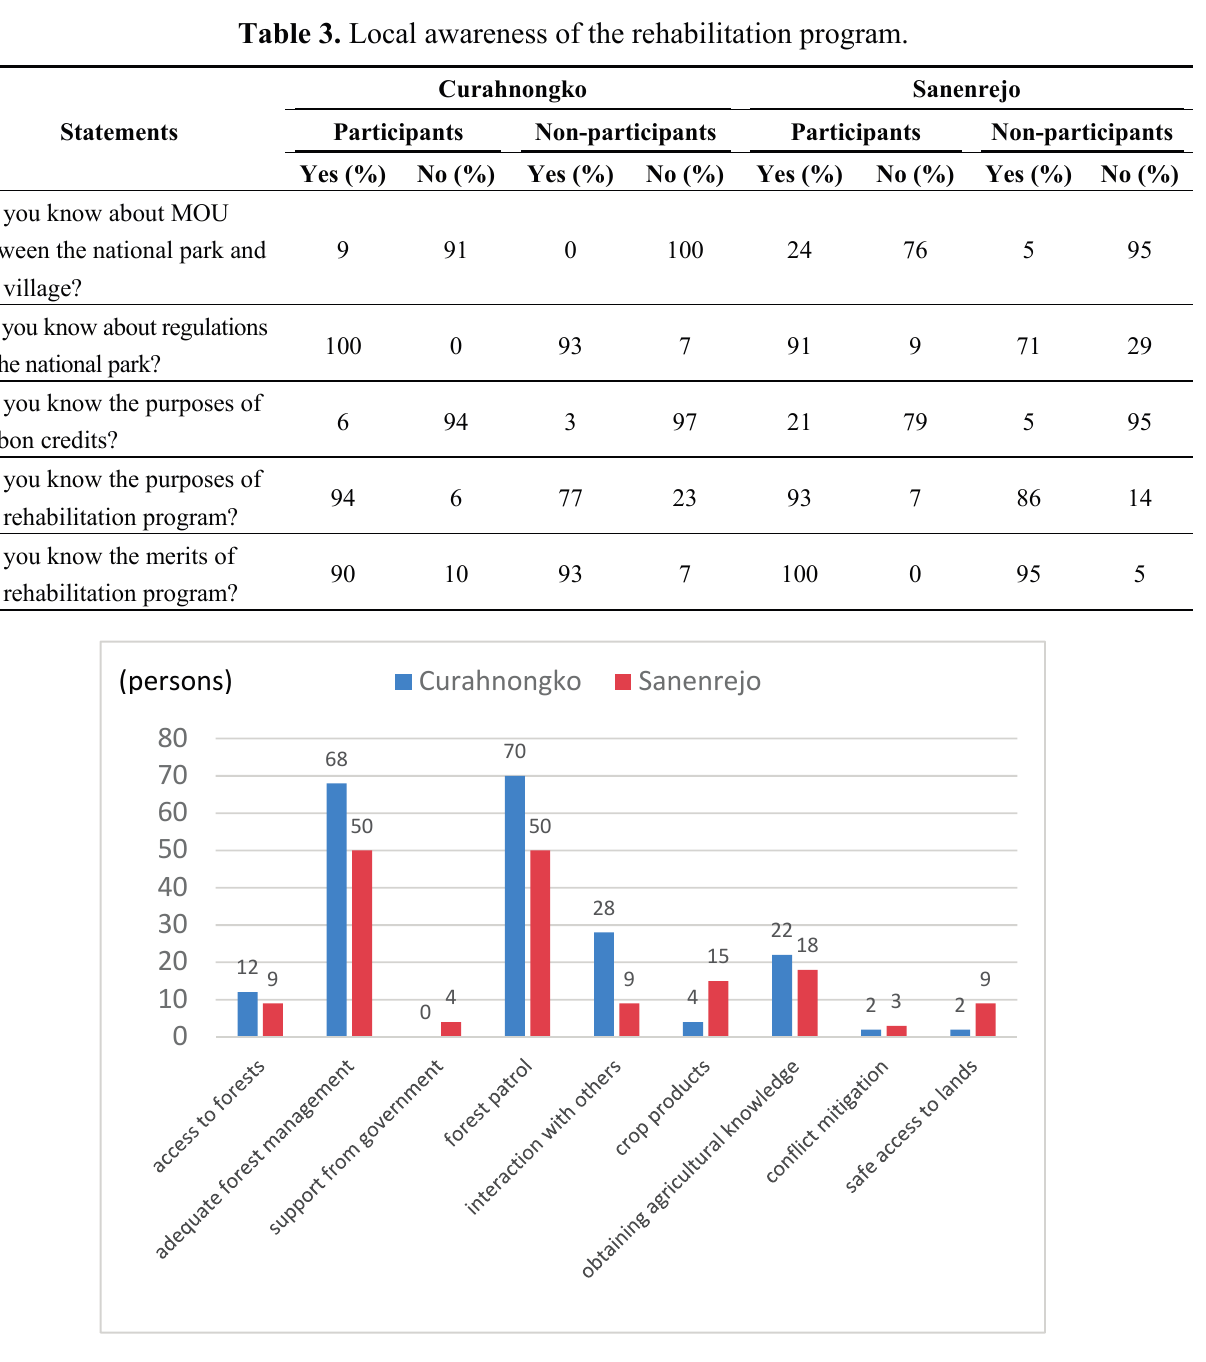
Figure 2. Local people’s motivations for participating in the rehabilitation